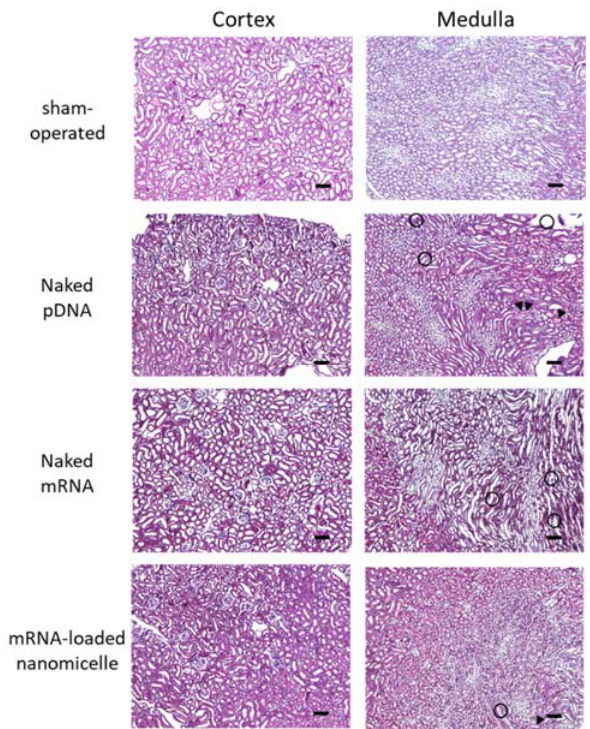
Figure 5. Histological assessment after renal pelvis injection of messenger RNA (mRNA) or plasmid DNA (pDNA). Mice were injected with luciferase (Luc2) mRNA or pDNA by renal pelvis injection. The kidneys were resected 24 h after the injection, followed by histological analysis of 4 µm paraffin sections prepared with hematoxylin and eosin staining. The kidneys of sham-operated mouse were also assessed as a negative control. Objective lens: ×10 lens. Scale bars represent 100 µm. head arrow, hyaline casts; circle area, mononuclear infiltration.